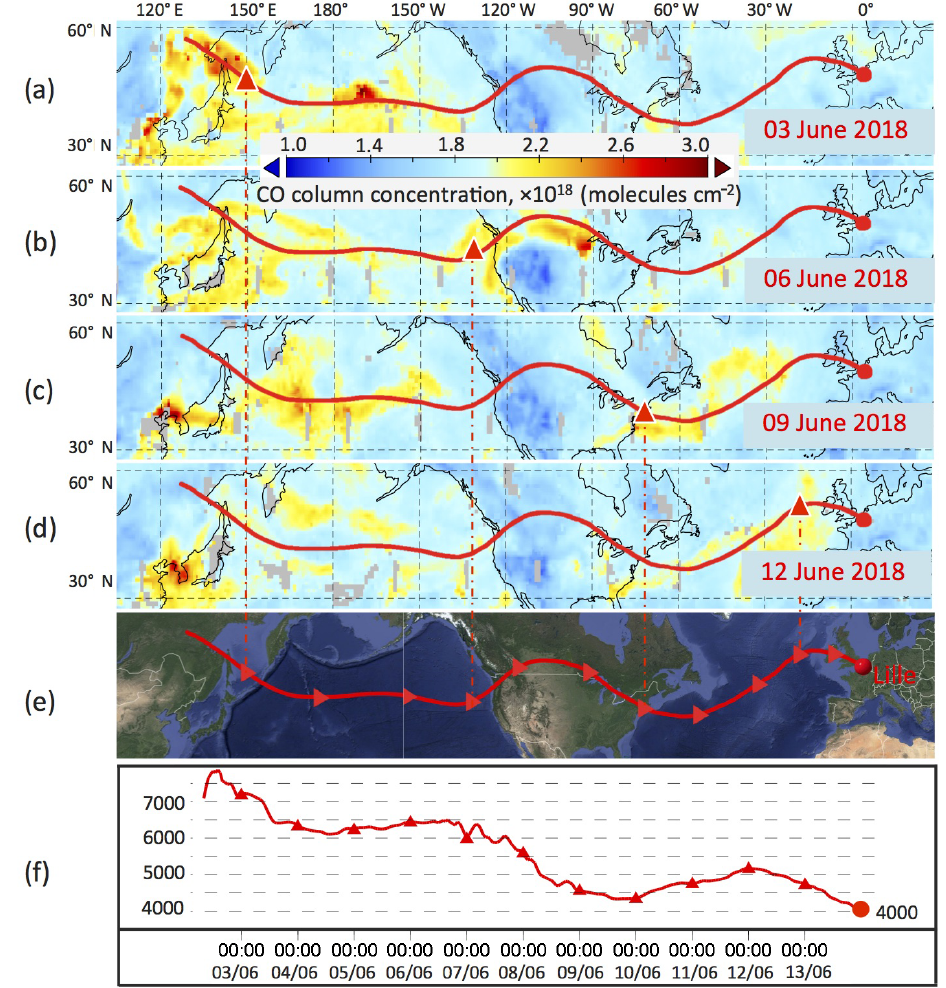
Figure 8. Ten-day backward trajectories for the air mass in Lille at an altitude of 4000m on 14 June 2018 at 00:00UTC. Panels (a) – (d) show the trajectory pathways overlaid with CO columnar concentration maps retrieved from AIRS data. The triangles represent the location of the traced air mass on corresponding dates. Panels (e) and (f) show the trajectory and vertical propagation of air